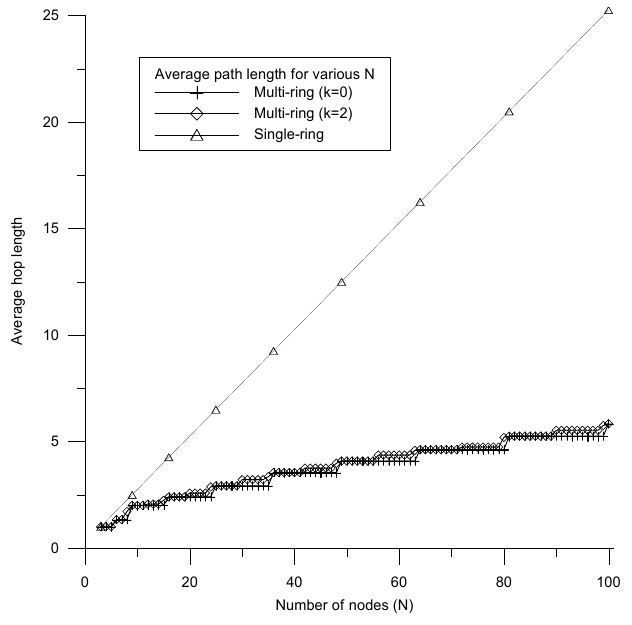
Figure 8. Average hop length of min-path algorithm for various N .